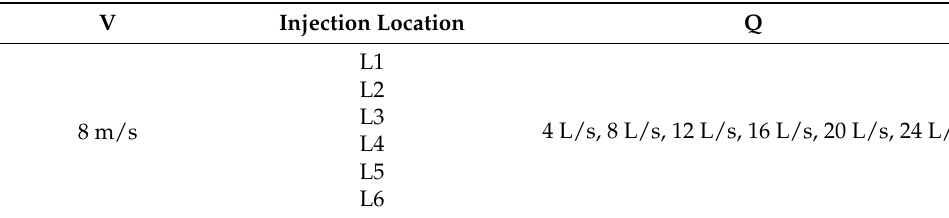
Table 3. Working conditions for the simulation of SWATH moving in calm water with different injection locations and airflow